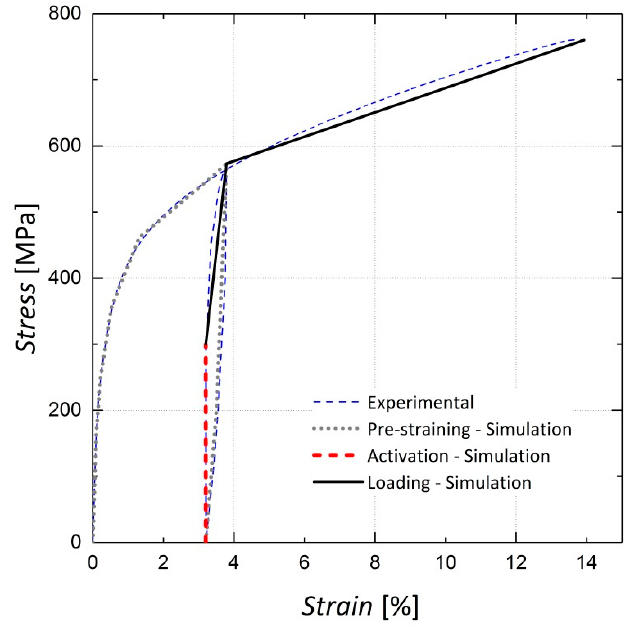
Figure 3. Curve defining the iron-based shape memory alloy (Fe-SMA) tensile behavior in ABAQUS.